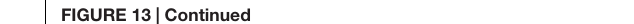
FIGURE 13 | Continued transgenic lines expressing the acdS gene under the control of the root-specific rolD promoter or the constitutive CaMV 35S promoter. Error bars indicate the range of two pools of seed each from four plants. Upper panel shows total oil content and the lower panels show fatty acid levels under various salt conditions. Fatty acids are as follows: myristic acid (14:0), palmitic acid (16:0), palmitoleic acid (16:1), stearic acid (18:0), oleic acid (18:1), linoleic acid (18:2), α -linolenic acid (18:3), arachidic acid (20:0),